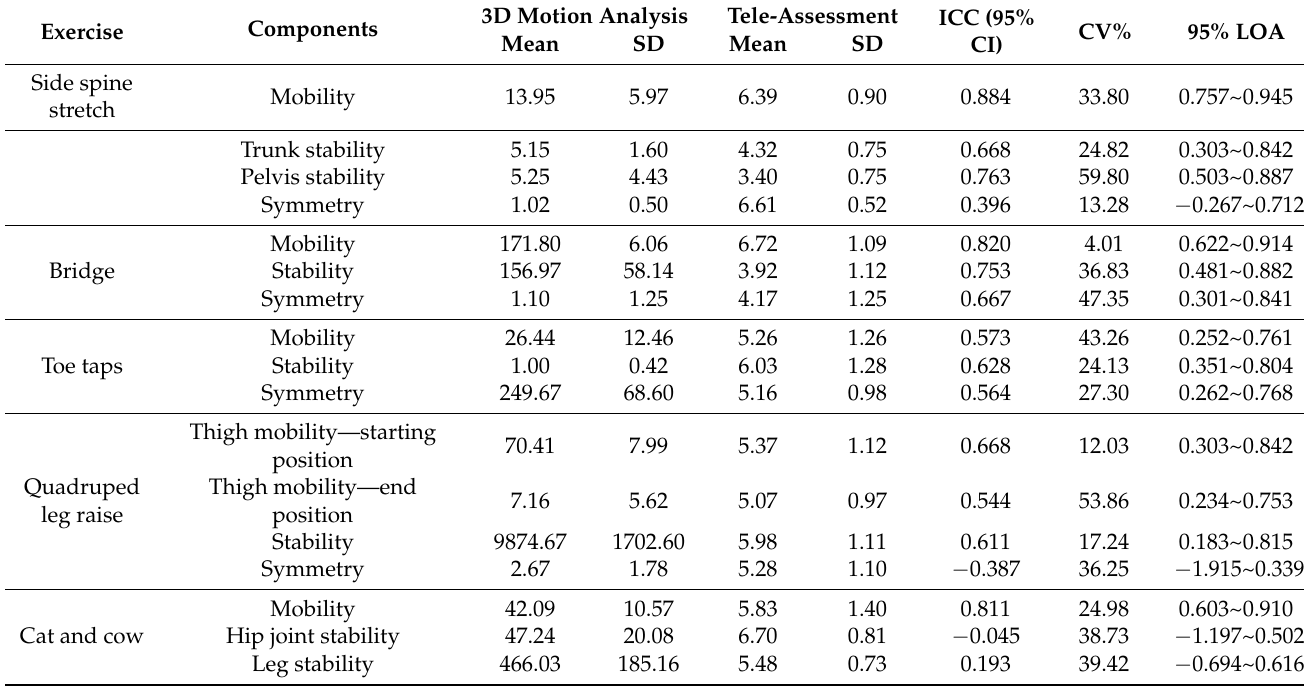
Table 2. Concurrent validity of the raters in tele-assessment using a video conference